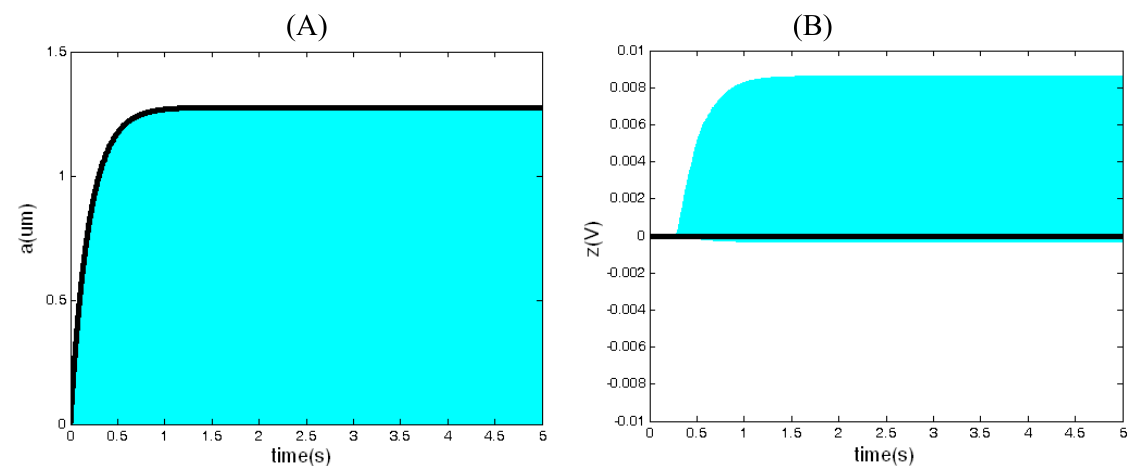
Figure 8. Closed-loop response (gray) and averaged equation simulation (black) when 0.7 V V   . (A) The curve of the drive displacement with time. (B) The curve of the ref refo output of integrator z(t) with